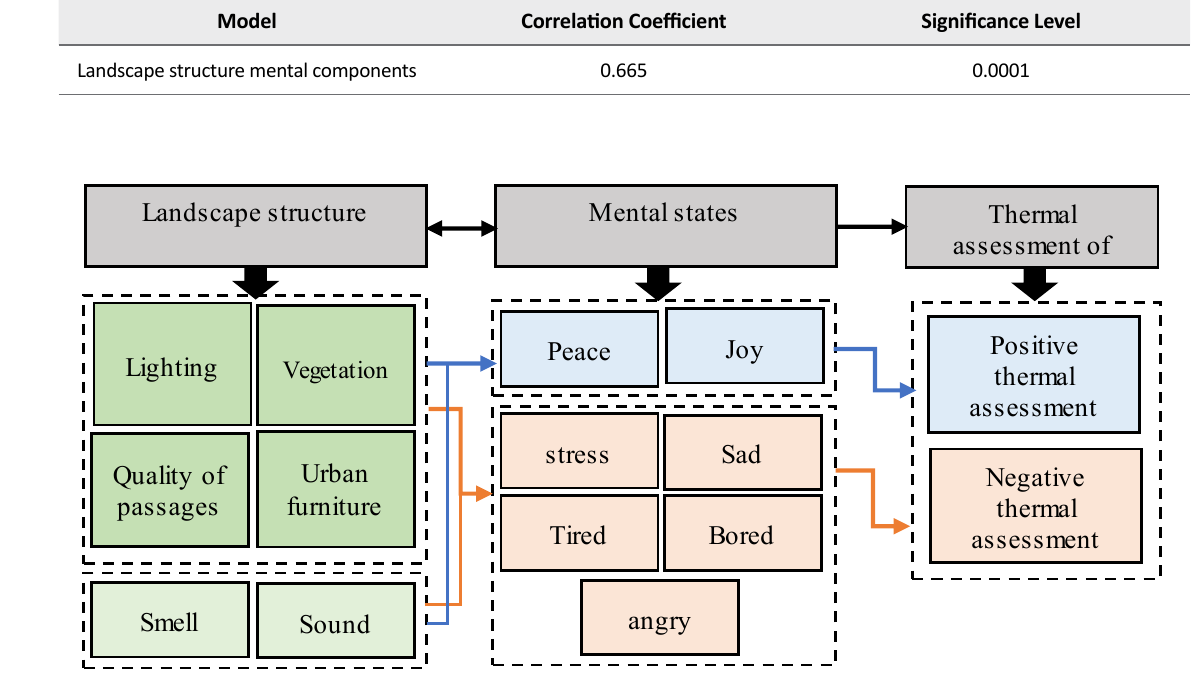
Figure 14: The Relationship Between Landscape Structure and the Mental Figure 14. The relationship between landscape structure and the mental states